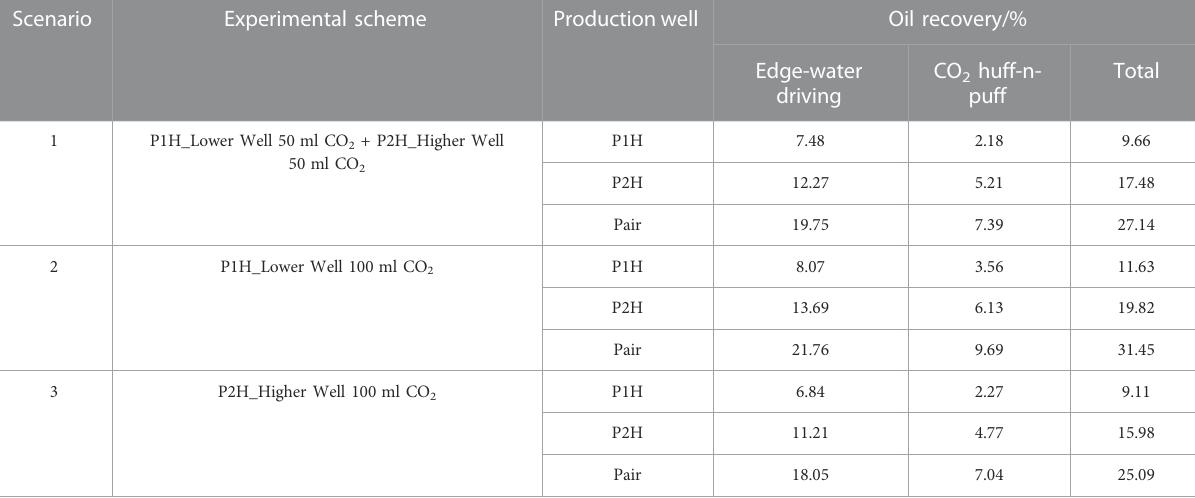
TABLE 6 Experimental results of CO 2 huff-n-puff conducted in 3D physical models.